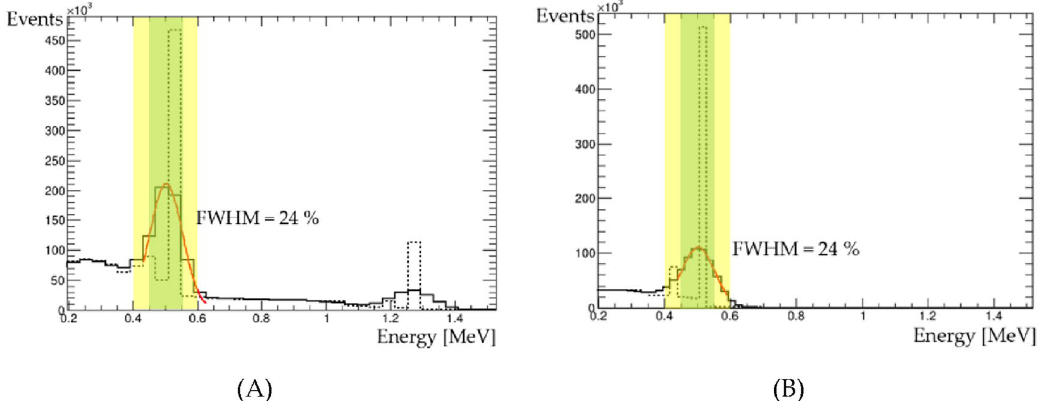
Figure 5. Energy spectra of 511 keV γ-rays from the ( A ) 22 Na source and ( B ) 18 F source simulated using a BGO scintillator in the KAPAE detector. The solid line considers the statistical noise fluctuation, but the dotted line does not. The yellow shade denotes the 2σ range, and the green box denotes the 1σ range. The red line is a Gaussian fit to the data.